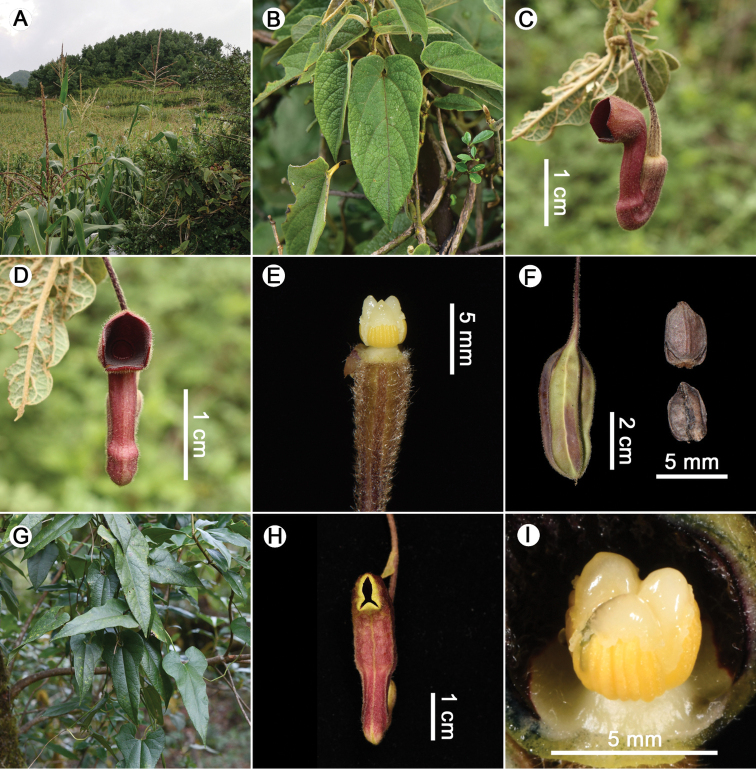
A–FIsotrema
brevilimbum X.X.Zhu, Jun Wang & F.Cao. A Habitat B leaves C lateral view of flower D frontal view of flower E anthers and gynostemium F capsule G–II.
wardianumG habit H frontal view of flower I anthers and gynostemium. A Photographed by F. Cao B, E, F photographed by X.X. Zhu C, D photographed by G. Liu G photographed by C. Liu H, I photographed by J.D. Ya.